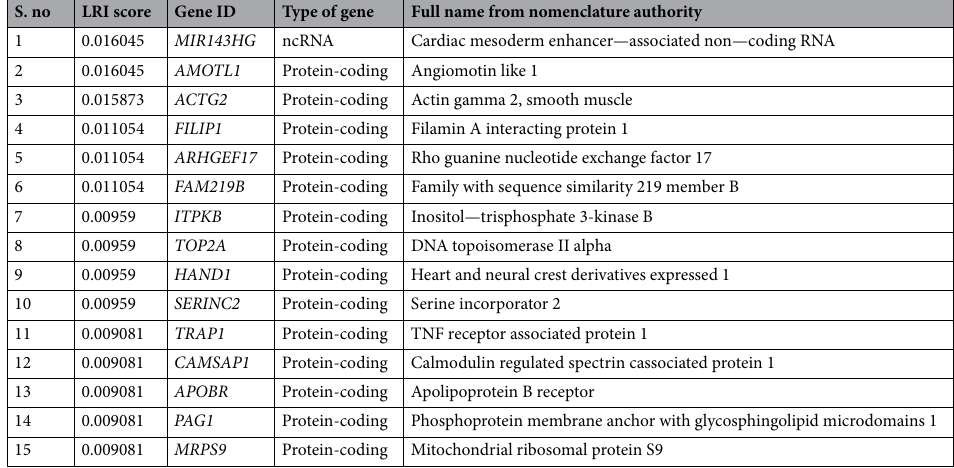
Table 1. LRI score of top 15 salient genes with their types and full name from nomenclature